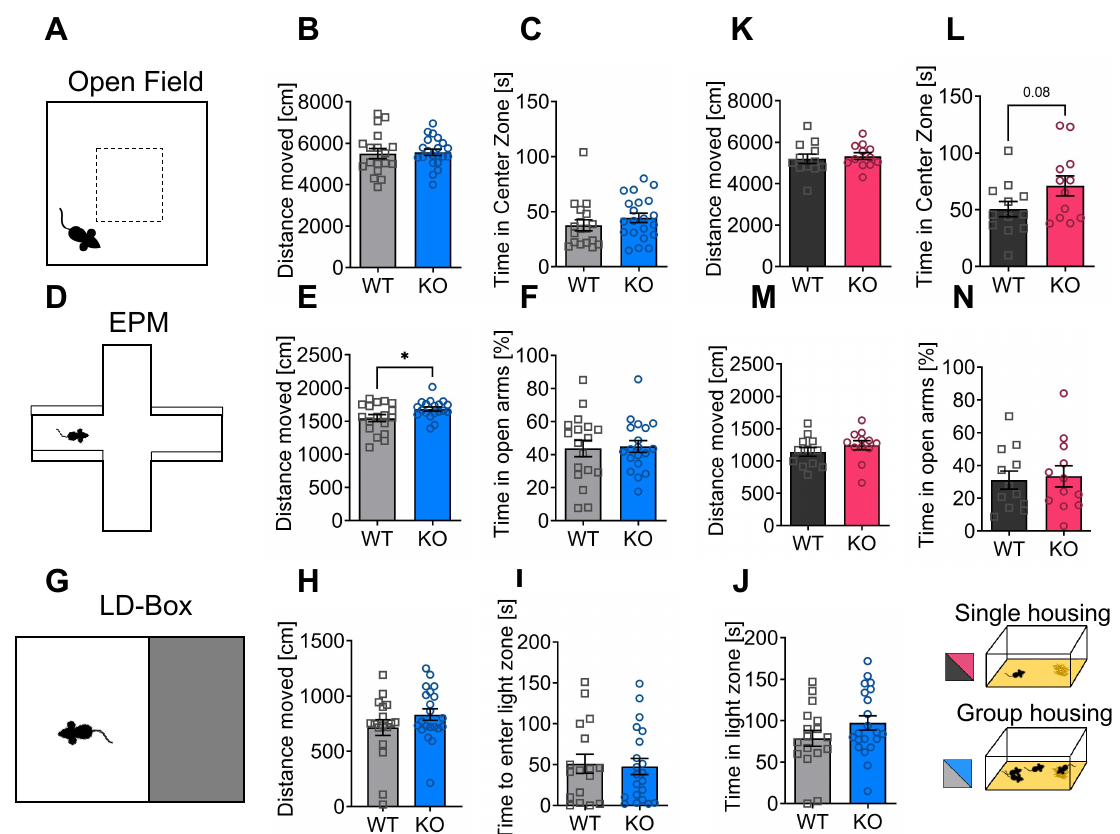
Figure 2. Depletion of p62 does not result in increased anxiety. ( A ) Illustration of the open field arena and the center zone (20 cm × 20 cm). ( B ) Both genotypes moved an equal distance in the open field arena. ( C ) The time p62 KO and WT mice spent in the center was similar. ( D ) Schematic view of elevated plus maze. ( E ) p62 KO mice moved a significantly longer distance in the elevated plus maze compared to WT mice. ( F ) The time spent in the open arms of the elevated plus maze was almost identical. ( G ) Schematic illustration of the light–dark box test. ( H ) Distance moved in the light zone of the arena was similar in WT and KO mice. ( I ) Time mice needed to re-enter the light arena was almost identical. ( J ) The time mice spent in the light arena was comparable. ( K ) WT and p62 KO mice moved a comparable distance in the open field. ( L ) p62 KO mice spent slightly more time in the center of the open field than their WT littermates. ( M ) WT and p62 KO mice moved a comparable distance in the elevated plus maze. ( N ) Time spent in the open arms of the elevated plus maze was comparable between genotypes. * p < 0.05 (unpaired t -test). Squares and circles represent single replicates. All error bars represent ± SEM. Group 1 (B-J group housing, blue): 3–4 months old, male; WT = 12, KO = 12. Group 2 (K-N single housing, red): 7 months, male: WT N = 18, KO N = 21. EPM, elevated plus maze; LD-Box, light–dark